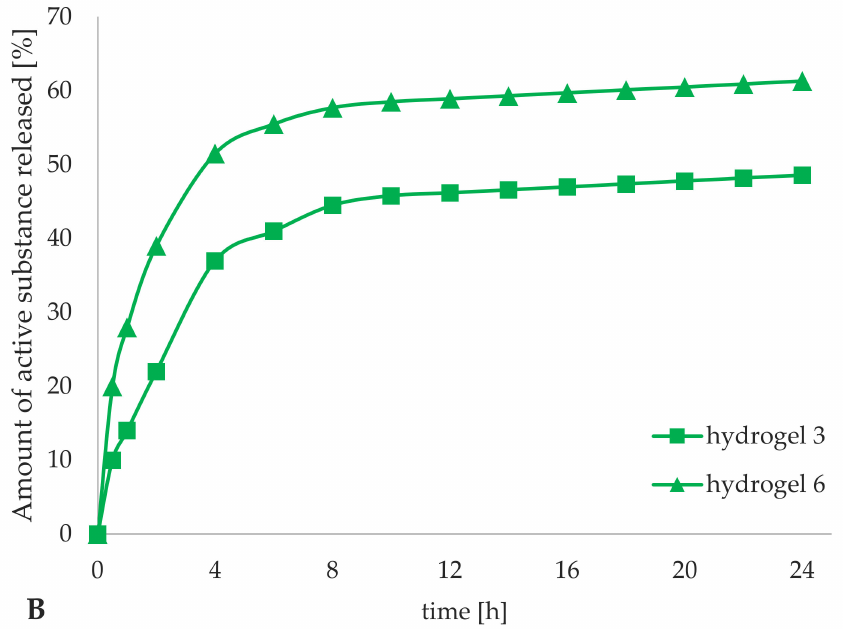
Figure 10. Release profiles of aucubin ( A ) and catalpol ( B ) for the hydrogel formulations (2, 3, 5, and